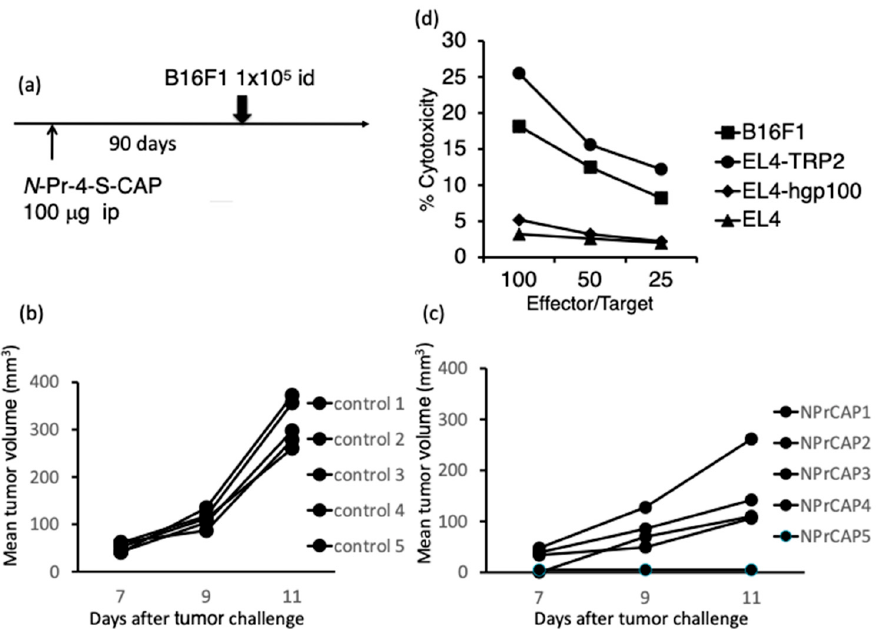
Figure 1. Administration of N -Pr-4- S -CAP induces anti-melanoma immunity and melanoma-specific CTLs in naïve mice. ( a ) Naïve mice were administered with N -Pr-4- S -CAP (100 µg in 100 µL propylene glycol/mice) or propylene glycol (100 µL/mice) by intraperitoneal injection. About six weeks after the N -Pr-4- S -CAP injection, mice that showed vitiligo or white hair were chosen. ( b , c ) Ninety days after the N -Pr-4- S -CAP injection, mice were transplanted intradermally with B16F1 cells (1 × 10 5 cells) and tumor diameters were measured. ( d ) Splenocytes from mice that had rejected B16F1 melanoma in N -Pr-4- S -CAP-treated group showed B16F1-specific and melanoma antigen (TRP2)-specific CTL activity.